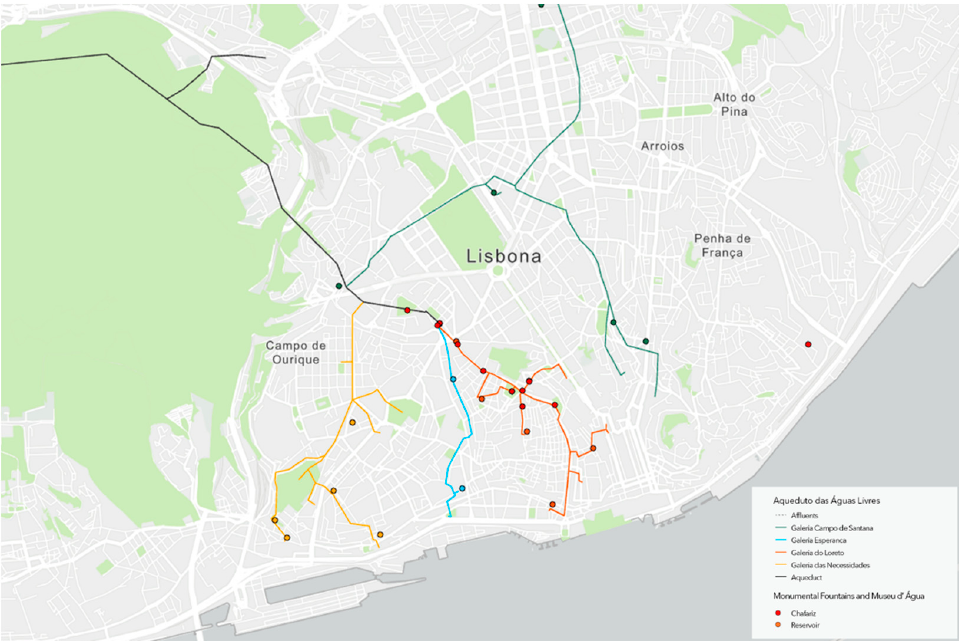
Figure 10. The 2D GIS map with layers of the Lisbon aqueduct system (Aqueduto das Águas Livres).